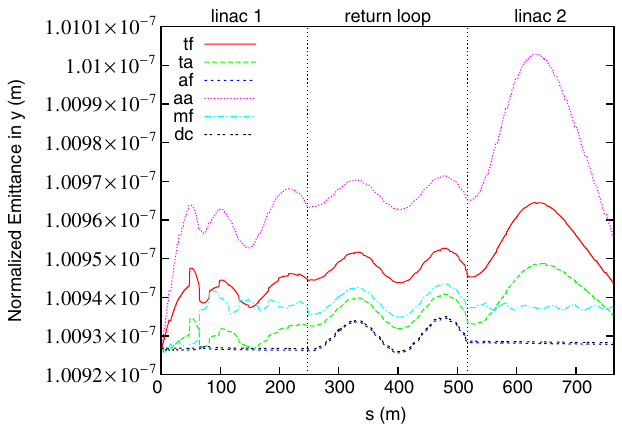
FIG. 6. (Color) Normalized emittance in the y direction for the six coupler configurations for Q